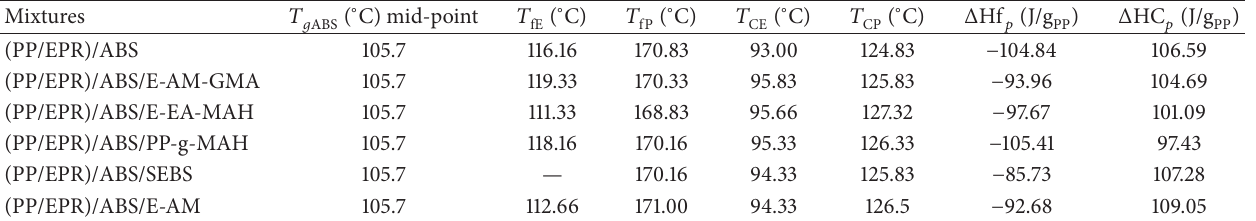
Table 7: Thermal characteristics of the blends (PP/EPR)/ABS/compatibilizer at rate of 1.5% of each one of the five compatibilizers.